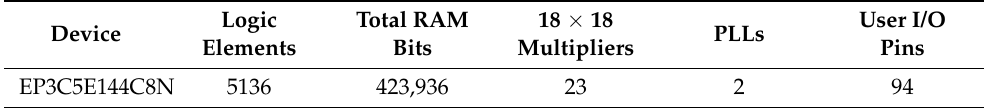
Table 4. EP3C5E144C8N